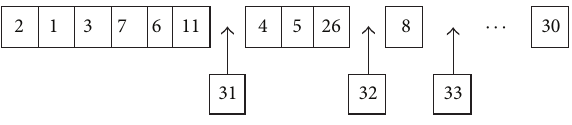
Figure 8: Sample gene